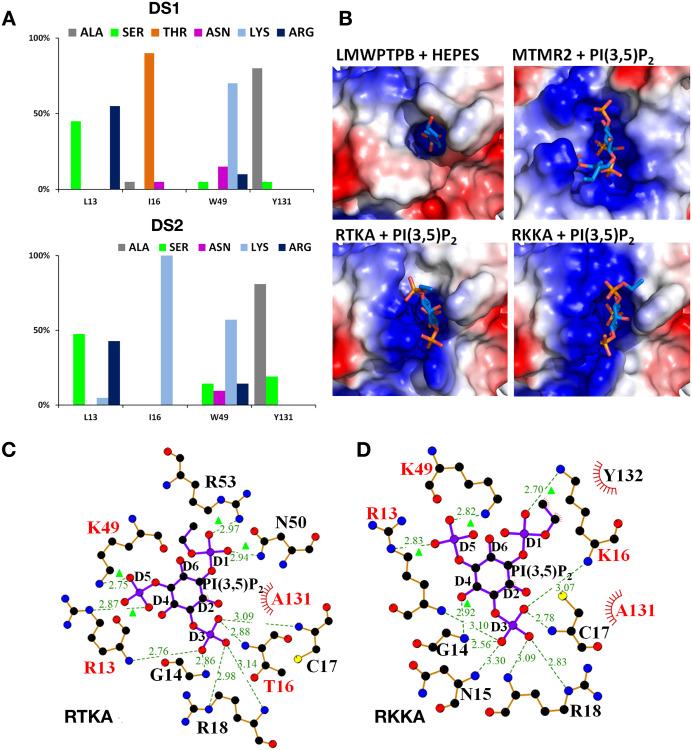
Analysis of mutations introduced during enzyme redesign.A) Analysis of the rate of mutation for each strategy. Design strategy 1 with LMW-PTP-WT as model (top) and 2 with LMW-PTPB-I16K as model (bottom) and PI[3,5]P2 as ligand. The rate of mutation (Y-axis) at each residue position (X-axis) is calculated using the top 20 Rosetta designs. B) The electrostatic surface potential of LMW-PTPB-WT in complex with HEPES (top left), and MTMR2 (top right), RTKA (bottom left), and RKKA (bottom right) in complex with PI[3,5]P2. Interactions calculated with LigPlot [47] between the ligand PI[3,5]P2 and the top two scoring Rosetta designs, DE1948 (RTKA)(C) and DE316 (RKKA) (D). In addition to the interaction between the P-loop residues and D3 phosphate oxygen atoms, new interactions are made with the D1 and D5 oxygen atoms (green triangles) by both newly introduced residues (R13, I16, K49 and K16) and existing WT residues (N50 and R53). Red text represents mutated residues, green dotted lines and green text represent interactions and distances respectively.